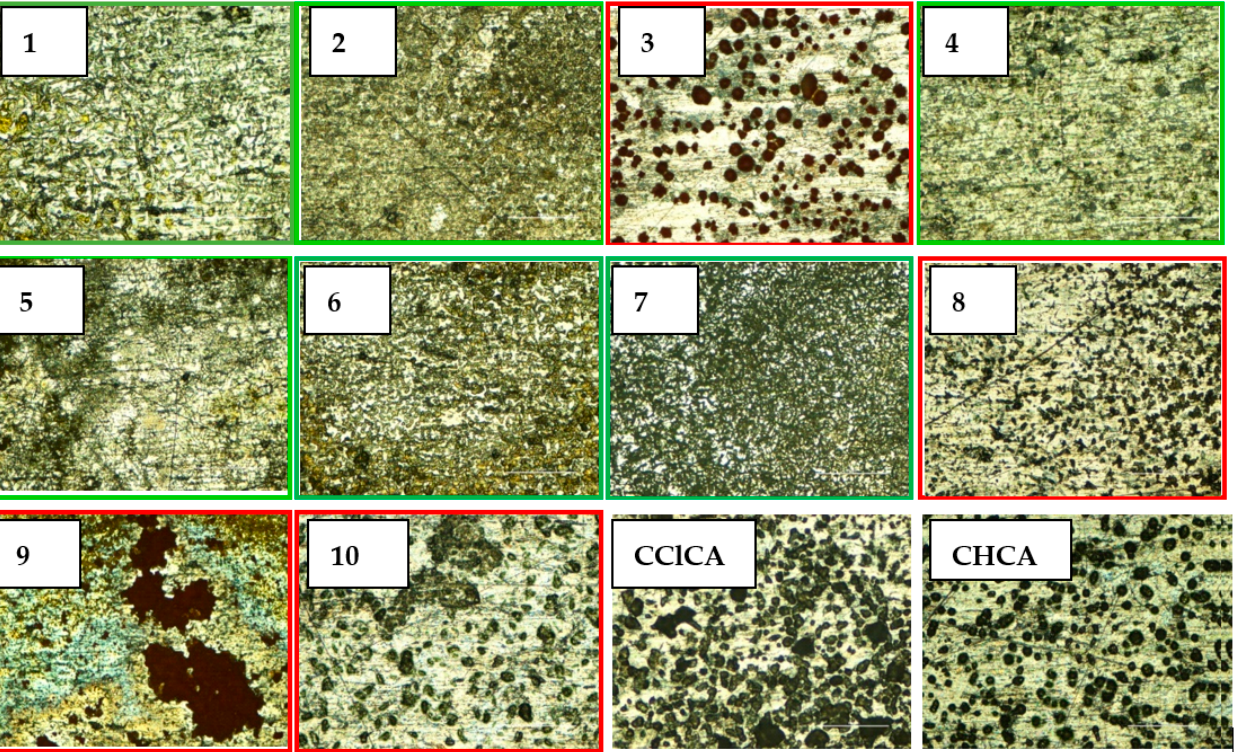
Figure 5. Microscope images of all the matrices ( 1 – 10 ) after dried-droplet mixing with the phospholipid standard mixture solution. The images of CHCA and ClCCA are reported for